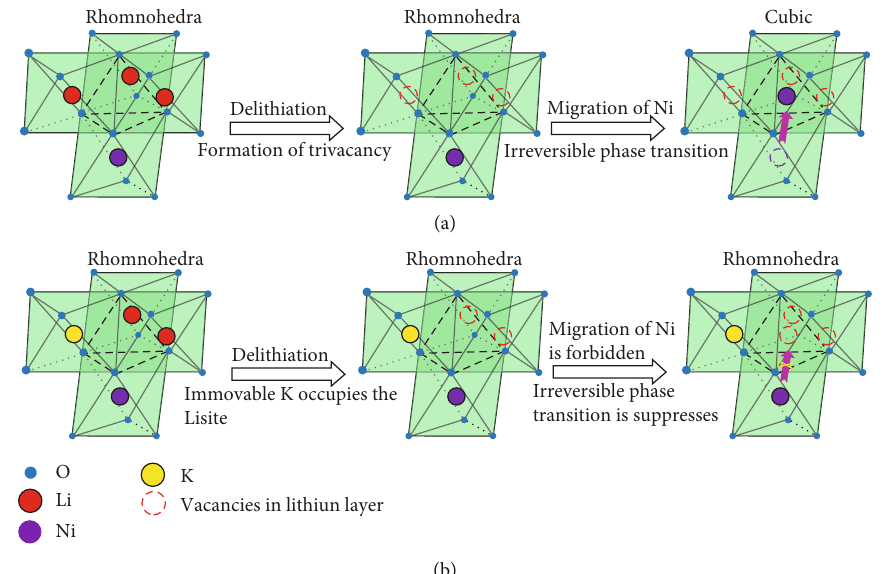
Figure 6: Schematic diagrams of the phase evolution routes for (a) potassium-free and (b) potassium-doped samples, which are built on an O -layered model with unrealistic radius ratios 3